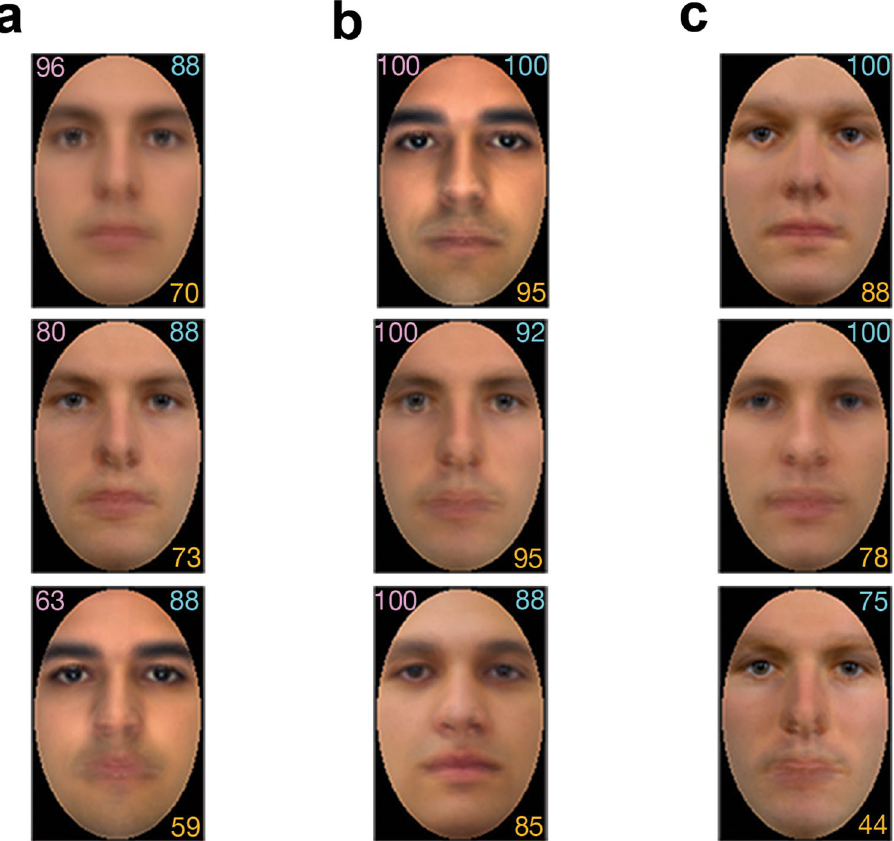
Figure 2. Examples of face reconstructions for participant NC. Results are shown separately for: ( a ) perceptual reconstructions; ( b ) memory-based reconstructions of learned faces and ( c ) memory-based reconstructions of famous faces (top to bottom: Jonah Hill, Chris Hemsworth, Jim Parsons) that participants were familiar with from their individual experience. Reconstruction accuracy (%) was estimated objectively through pixelwise image similarity (top left, a–b ); additionally, accuracy was assessed experimentally by the same participant (top right) or by an independent group of naïve participants (bottom right) for all types of reconstruction. (Corresponding stimulus images for ( a ) and ( b ) could not be reproduced due to copyright restrictions; all image reconstructions were generated using Matlab R2015b).